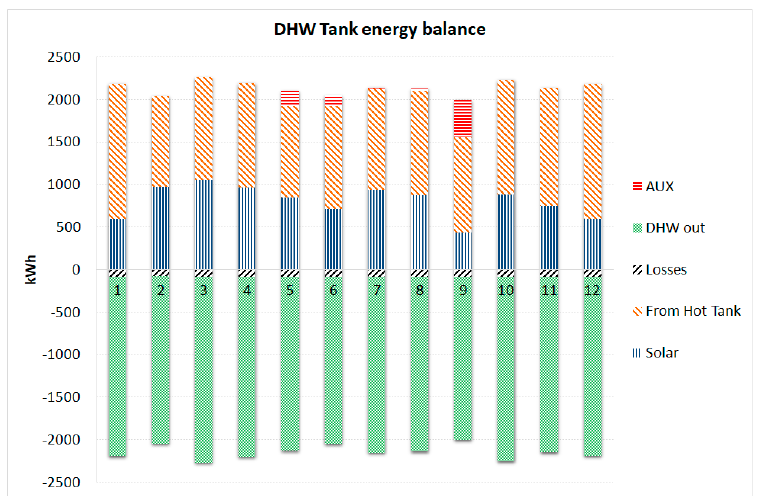
Figure 13. Energy balance for the DHW tank for the A3 alternative.